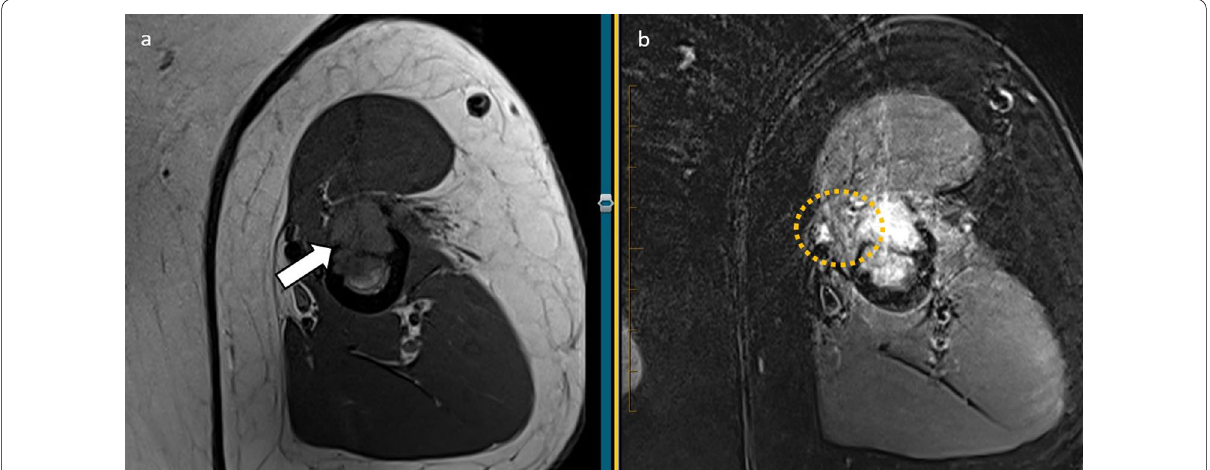
Fig. 18 Axial T1 and PDFS of a 70-year-old male with non-small cell lung cancer. There is a lytic destructive lesion in the mid-humeral shaft with cortical disruption and extraosseous extension (white arrow) extending into the deltoid attachment and the coracobrachialis muscle. While the musculocutaneous nerve is not confidently traced due to the motion artefact, it is expected to be in close contact with the lesion. Oedema signal within coracobrachialis muscle (yellow circle) can be either due to direct muscle involvement or